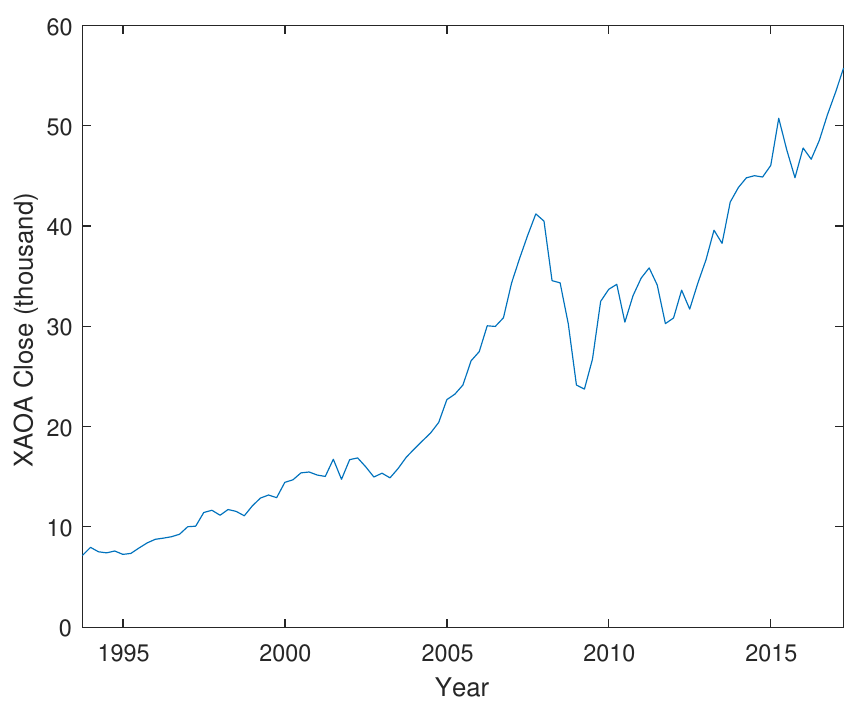
Figure A5. All Ordinaries Accumulated (XAOA).